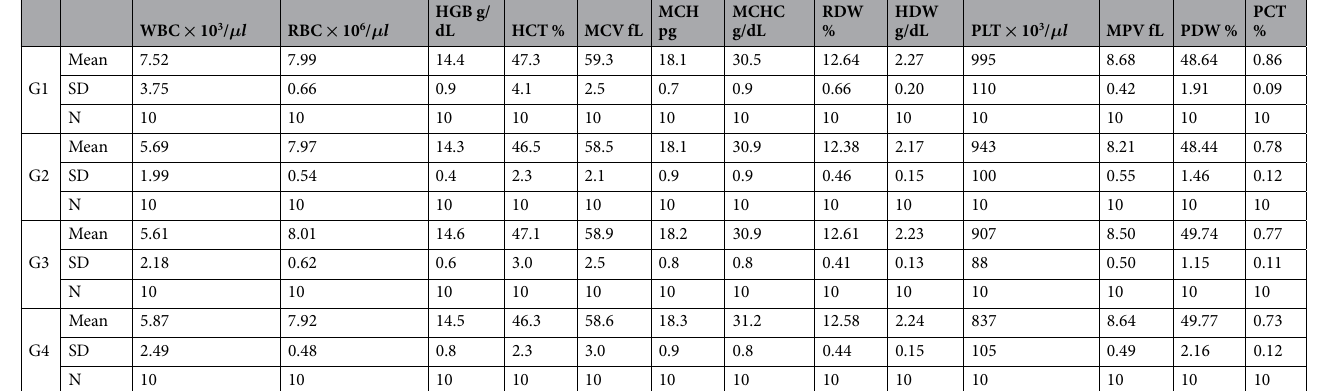
Table 3. Hematologic findings at 12 weeks (1). G: group, SD: standard deviation, N: number, WBC: white blood cells, RBC: red blood cells, HGB: hemoglobin, HCT: hematocrit, MCV: mean corpuscular volume, MCH: mean corpuscular hemoglobin, MCHC: mean cell hemoglobin concentration, RDW: red cell distribution width, HDW: hemoglobin distribution width, PLT: platelets, MPV: mean platelet volume, PDW: platelet distribution width, PCT: plateletcrit.